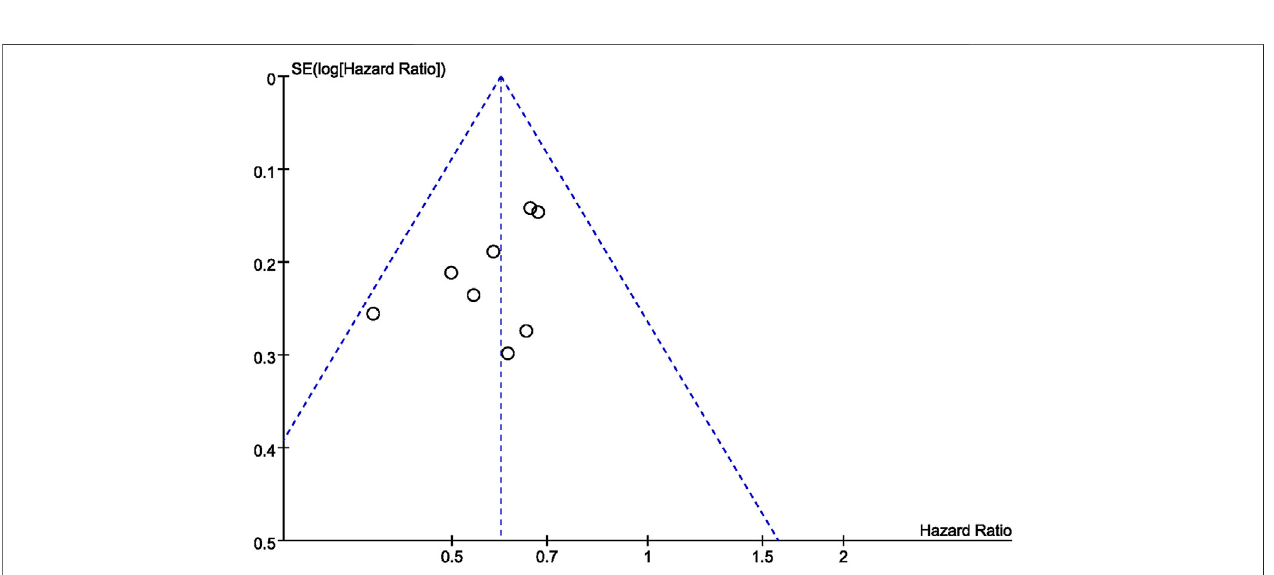
FIGURE 9 | Funnel plot for